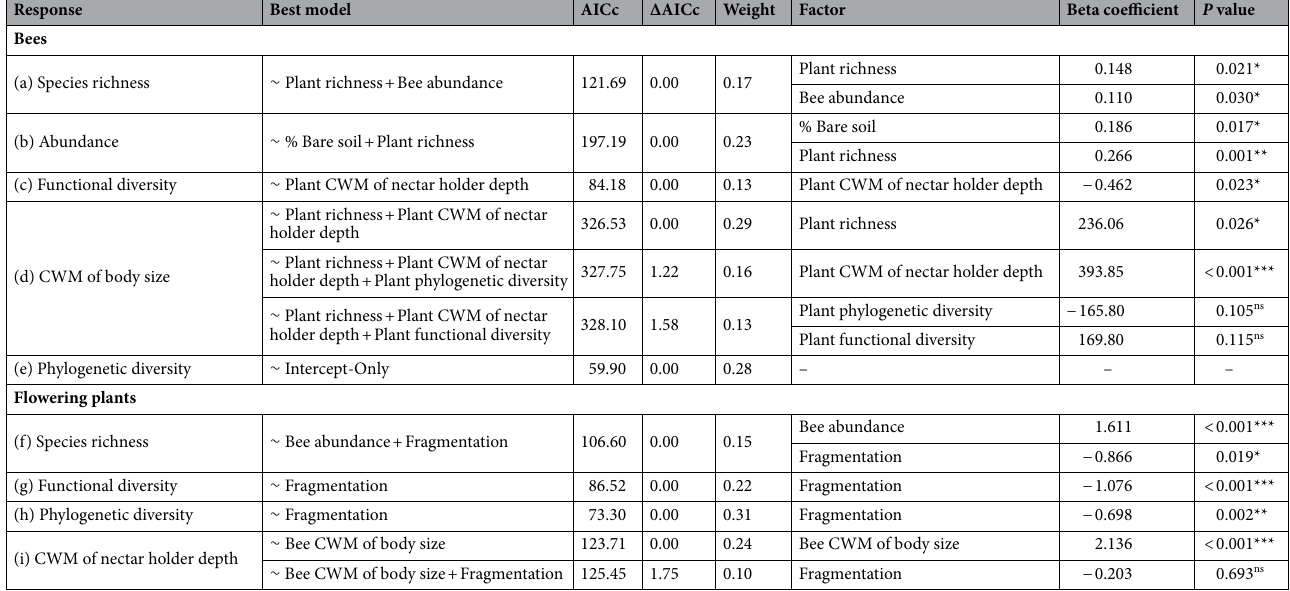
Table 1. Model selection statistics and model averaging coefficients (full average) for flowering plant and bee biodiversity metrics. ns = not significant; * P ≤ 0.05; ** P ≤ 0.01; *** P ≤ 0.001.